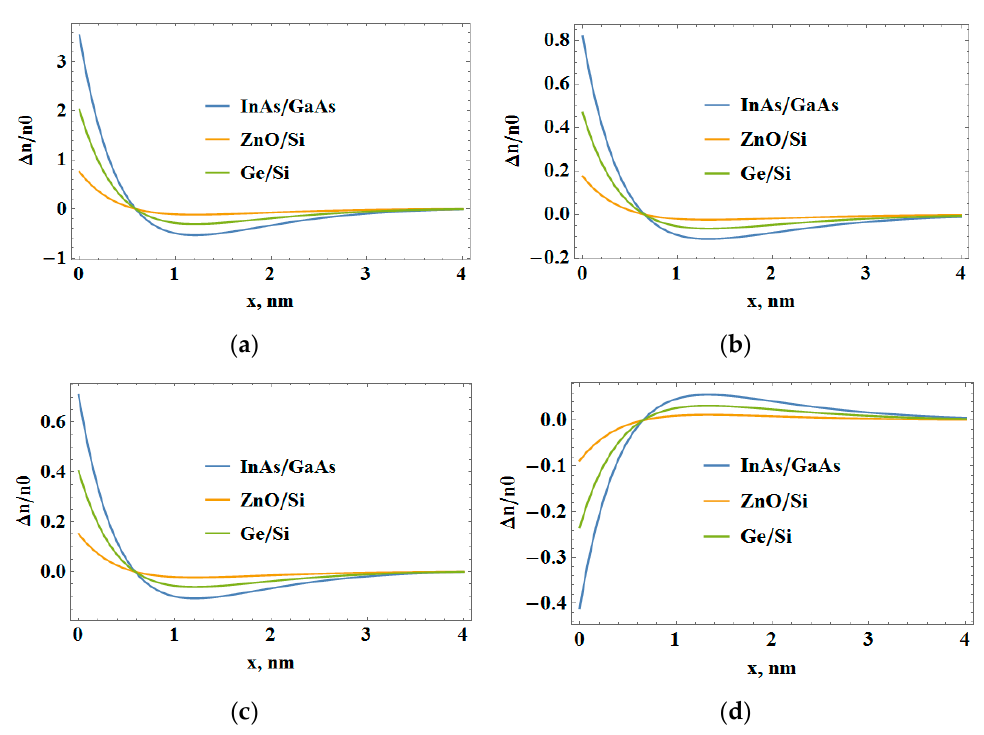
Figure 3. The spatial redistribution of the concentration of conduction electrons in the presence of various types of defects and at different average values of the electron concentration: ( a ) θ d = 10 eV, n 0 = 10 20 cm − 3 ; ( b ) θ d = 10 eV, n 0 = 10 18 cm − 3 ; ( c ) θ d = 5 eV, n 0 = 10 18 cm − 3 ; ( d ) θ d = − 5 eV, n 0 = 10 18 cm − 3 .